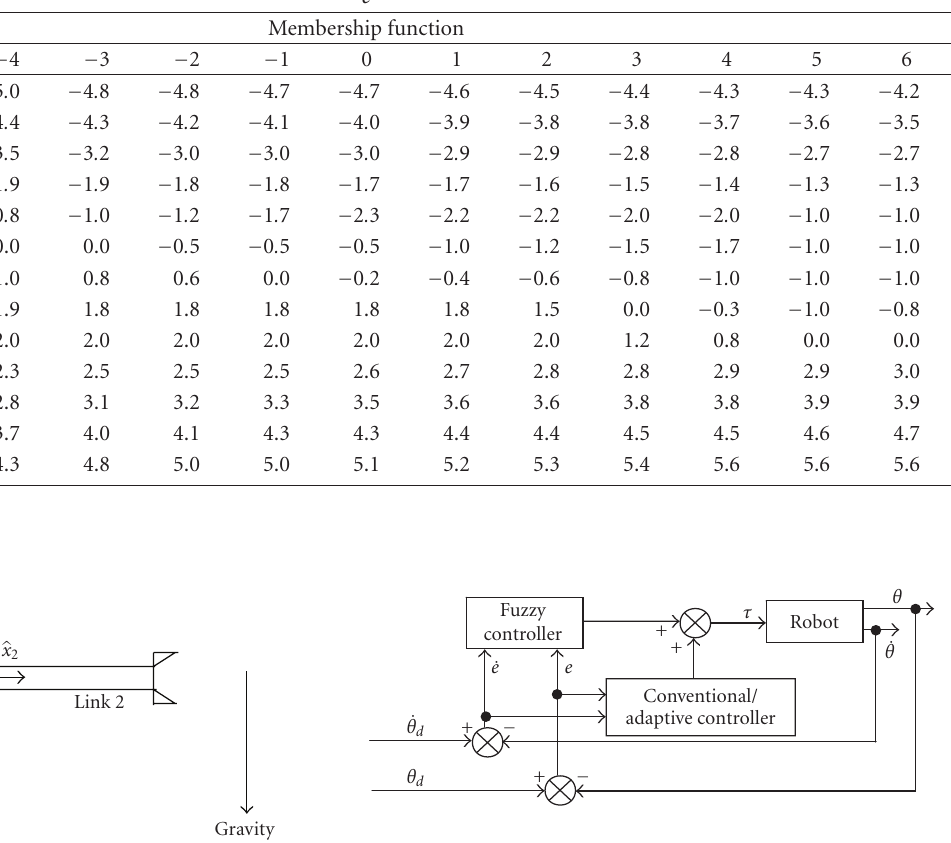
Figure 5: Hybrid fuzzy